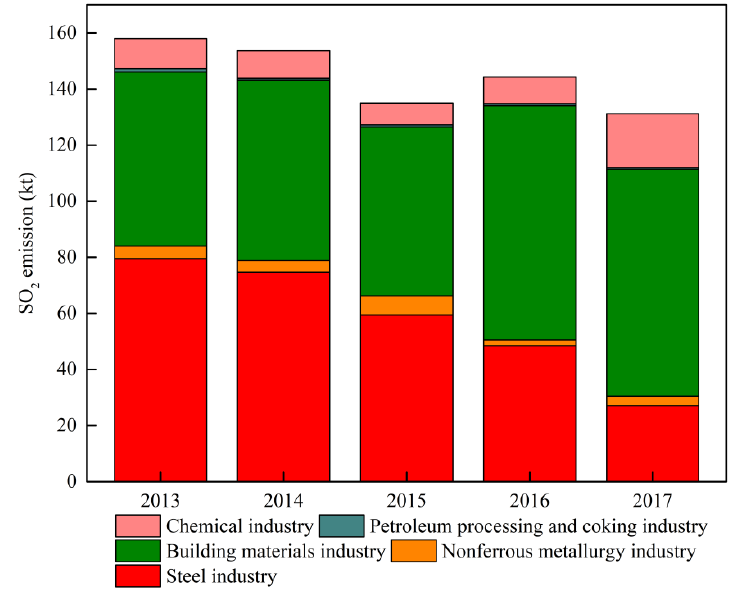
Figure 6. Trends in SO 2 emission from major industrial processes.